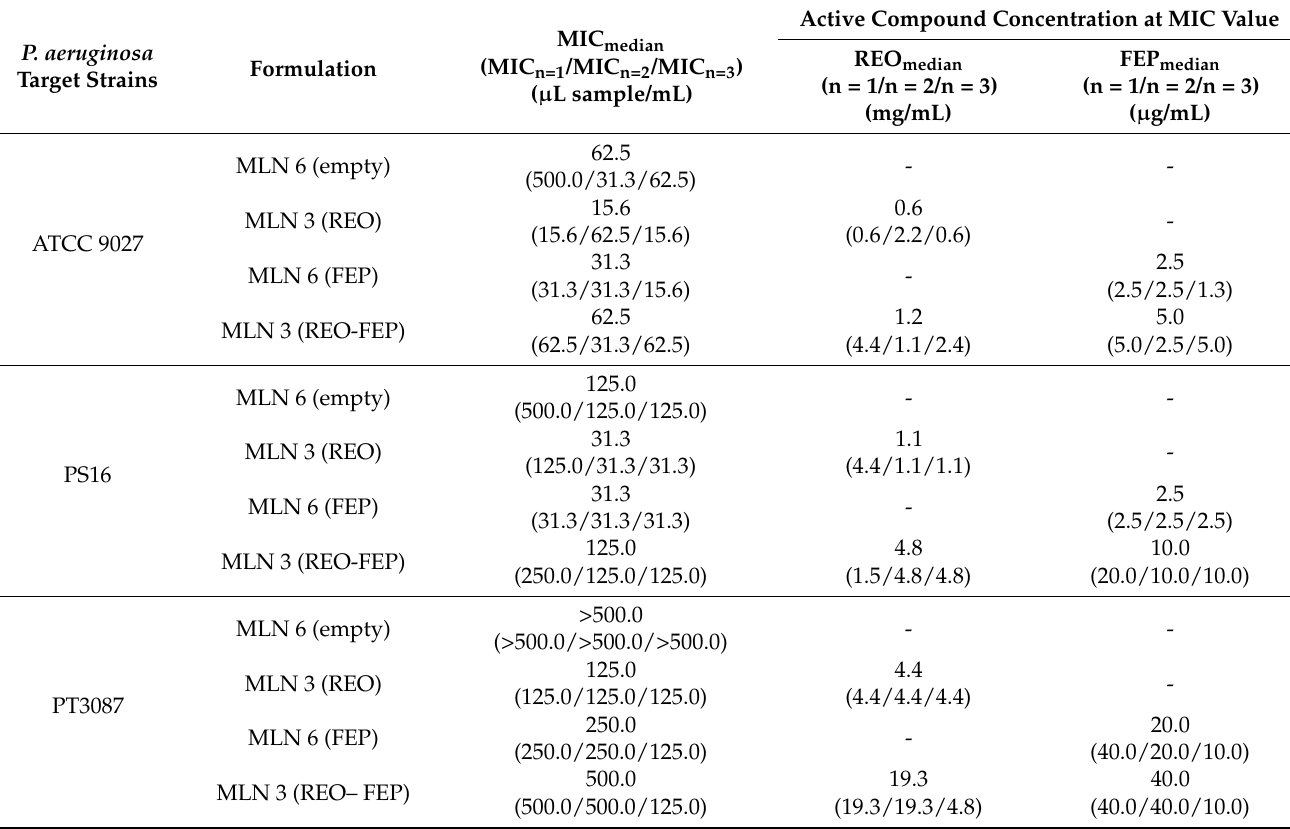
Table 6. MIC values of REO and FEP as part of loaded formulations and that of the formulation. MIC values are represented as the median of three independent